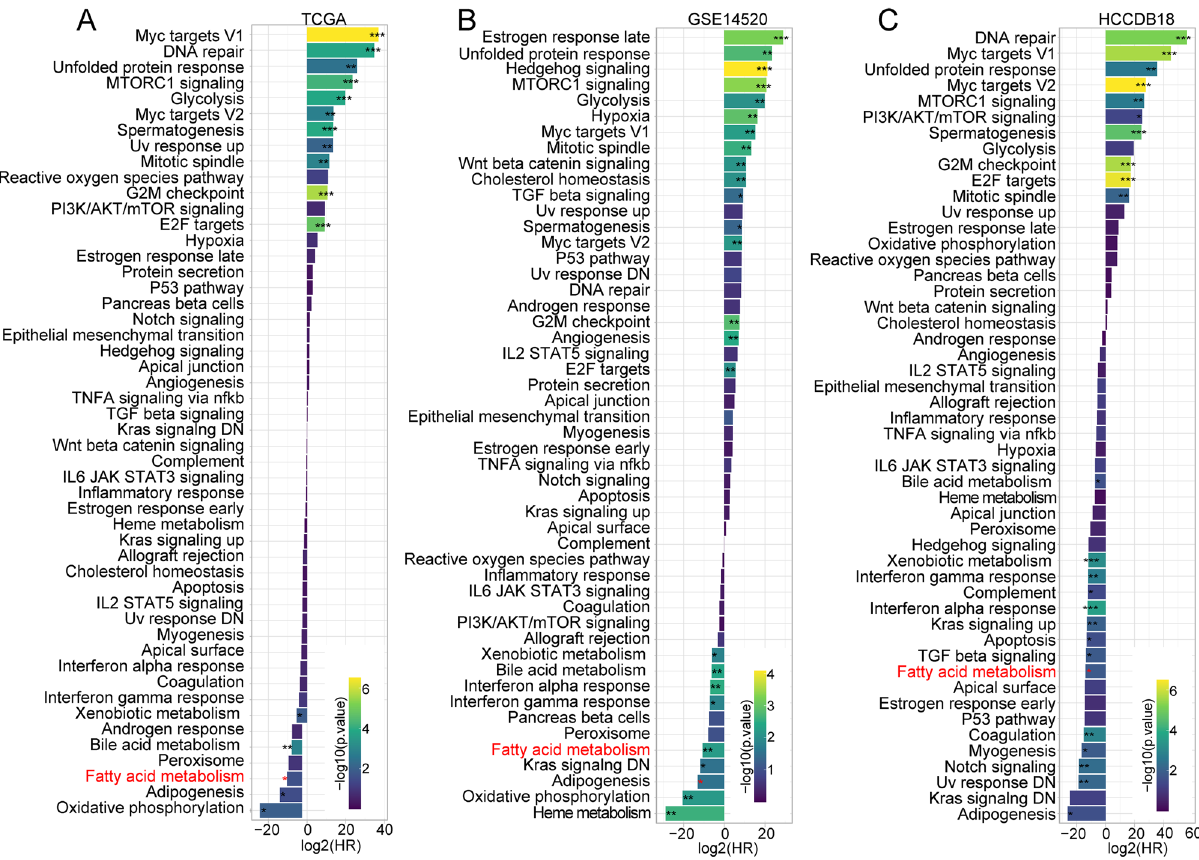
Figure 1. Hallmark pathways associated with prognosis ( A ) Univariate analysis of hallmark pathways in the TCGA database. ( B ) Univariate analysis of hallmark pathways in the GSE14520 database. ( C ) Univariate analysis of hallmark pathways in the HCCDB18